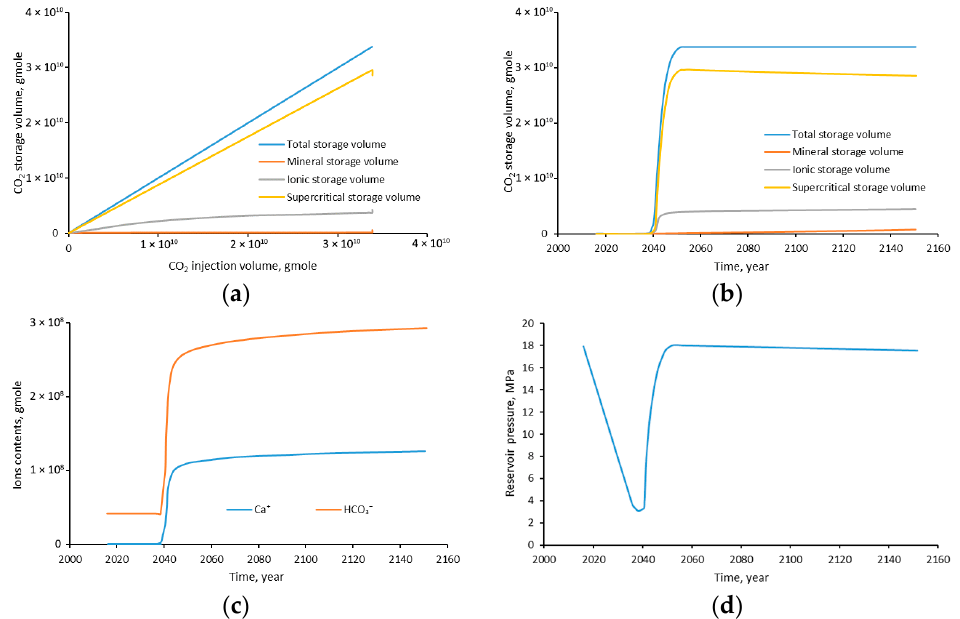
Figure 23. The variation curves of storage analysis. ( a ) Relation curves between CO 2 storage amount and injection volume under different storage mechanisms; ( b ) relation curves between CO 2 storage amount and development time under different storage mechanisms; ( c ) the variation curves of ions contents in irreducible water; ( d ) the variation curve of average reservoir pressure.